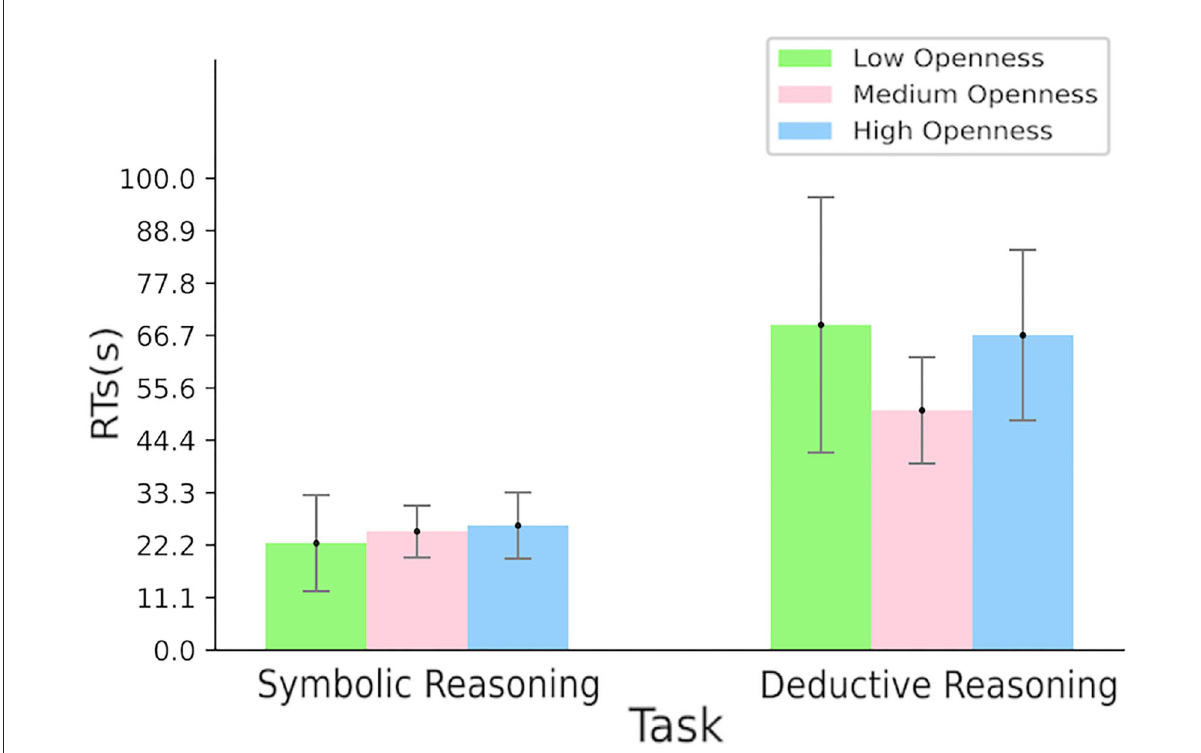
FIGURE4 Participants’ RTs according to the type of reasoning task—symbolic reasoning on the left-hand side and deductive reasoning on the right-hand side, according to the openness level—low, medium, and high openness corresponding, respectively, to green, pink, and blue bars.